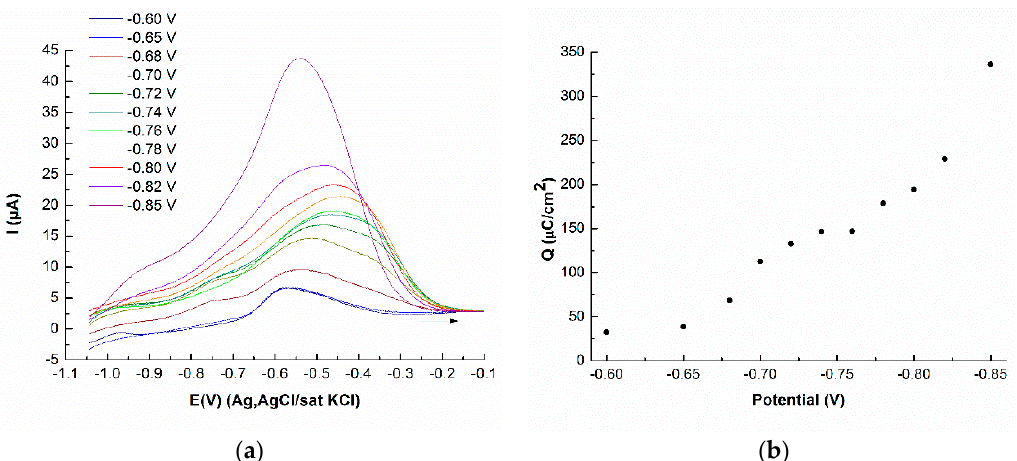
Figure 2 ( a ) Anodic stripping curves after potentiostatic deposition of Mo at different potentials (deposition time 15 min) on Ag(111) in NaOH 0.1 M. The scan rate is 50 mV·s − 1 . ( b ) Plot of the charge density (Q) involved in the stripping of Mo deposited on Ag(111) as a function of the deposition potential, at a constant deposition time of 15 min.